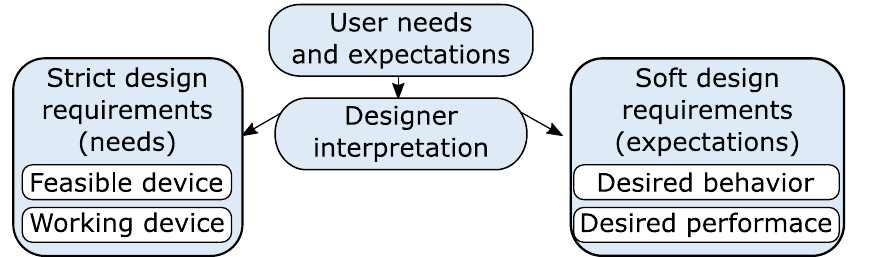
Figure 1. A scheme for modeling design